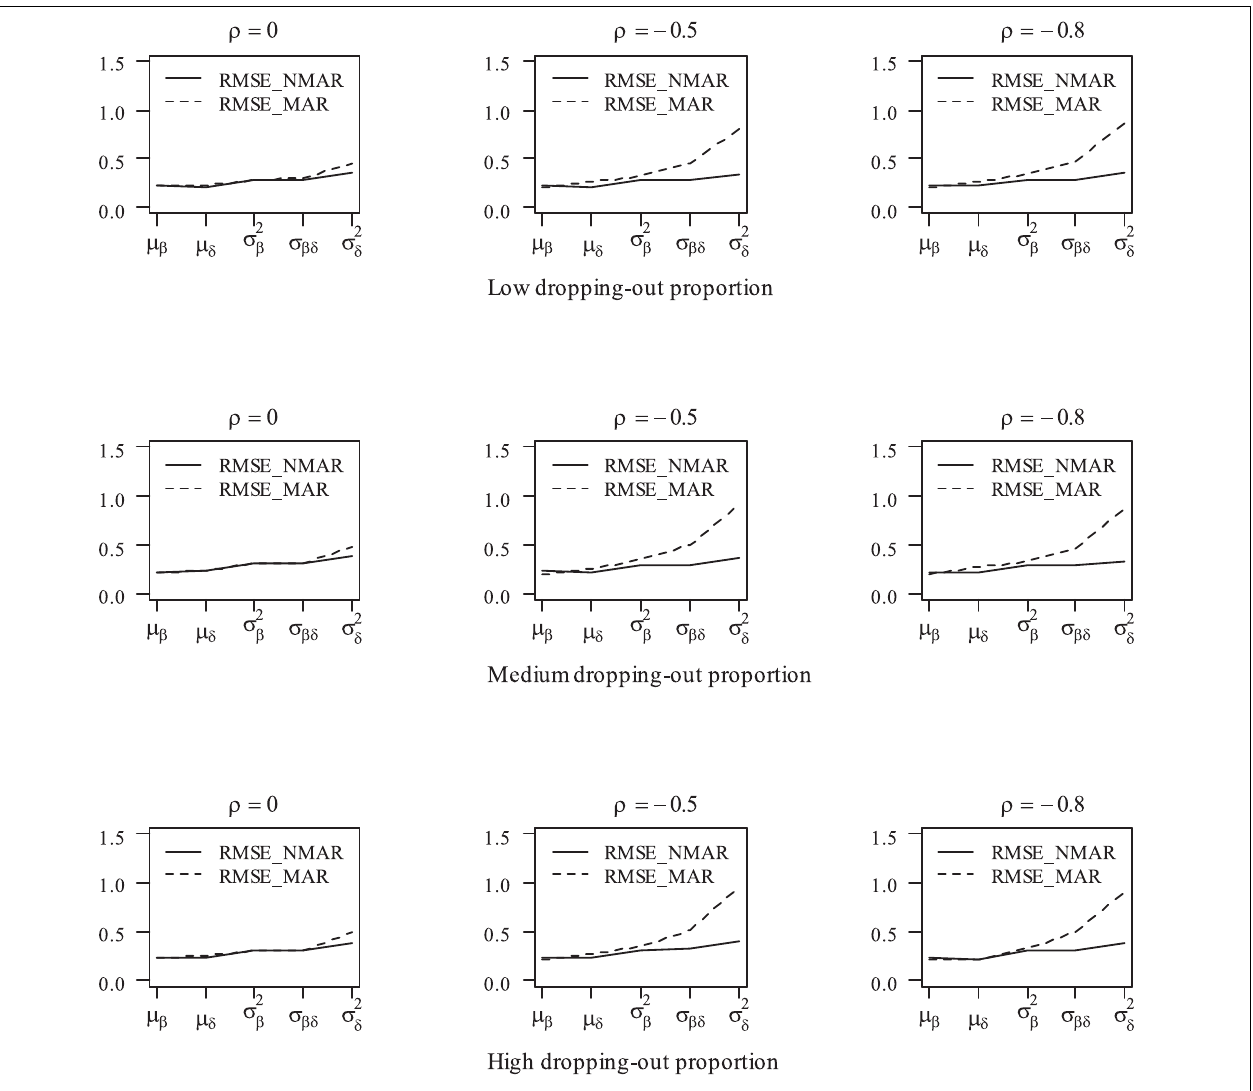
FIGURE 4 | RMSE of parameter estimates in the mean item vector and the item covariance matrix elements under different dropping-out proportions and correlations between θ h i and θ d i in simulation study III. Note that the Bias_NMAR is the bias of parameter estimates in the NMAR model, and Bias_MAR is the bias of parameter estimates in the MAR